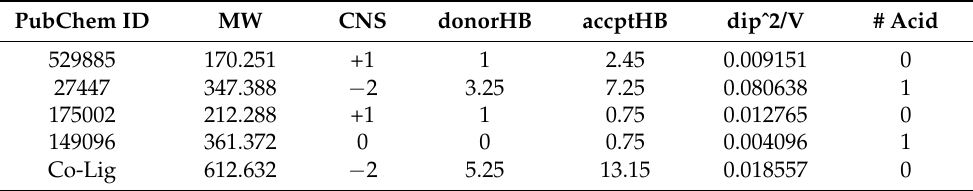
Table 1. Physicochemical properties of the ligands docked with the target proteins.